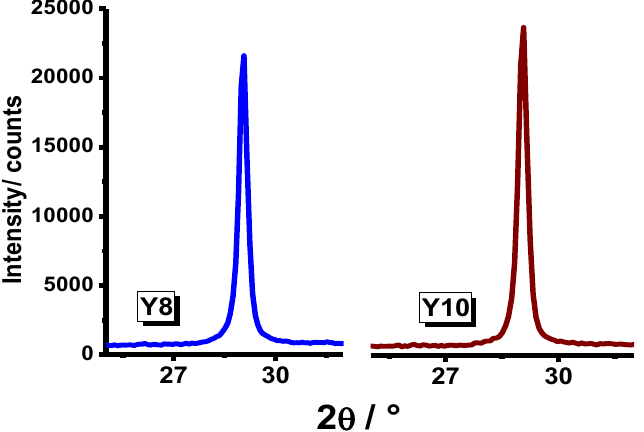
Figure 6. XRD pattern of Y 2 O 3 powder synthesized from yttrium nitrate and yttrium chloride using P-123 poloxamer in a molar ratio of P-123:Y = 2:1.